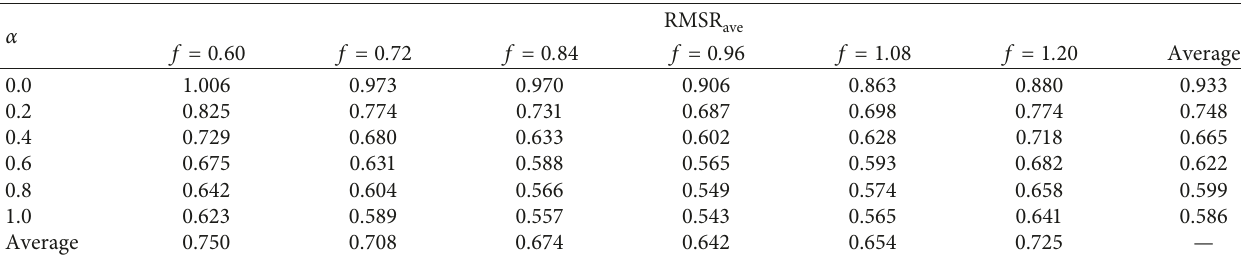
with different f and α . ave